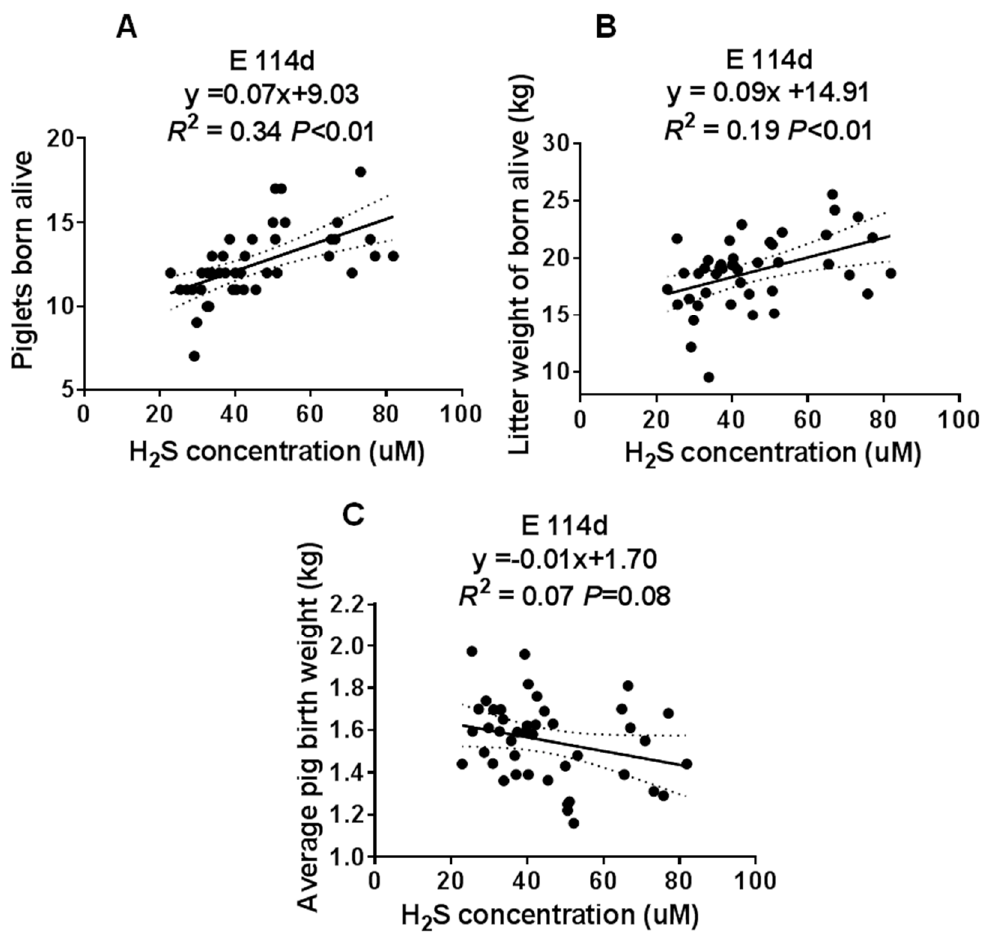
Figure 4. The correlation analysis of the maternal plasma H 2 S concentration at E114d and the sow’s reproductive performance. ( A ) Piglets born alive. ( B ) Litter weight of piglets born alive. ( C ) Average pig birth weight. Met / Lys ratios 0.27, n = 8; Met / Lys ratios 0.32, n = 9; Met / Lys ratios 0.37, n = 10; Met / Lys ratios 0.42, n = 7; Met / Lys ratios 0.47, n = 7.